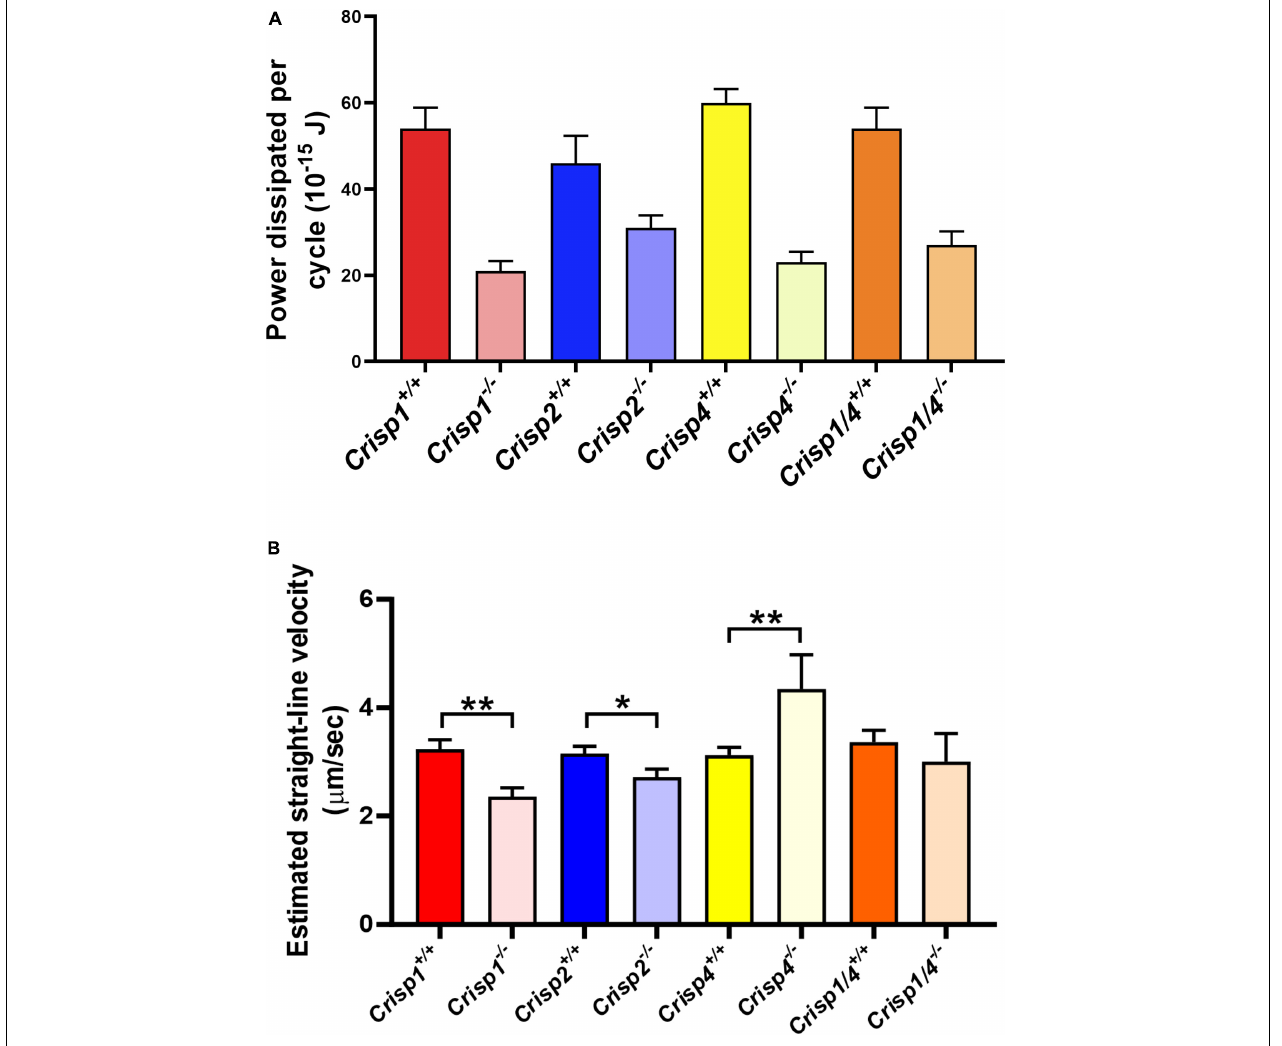
FIGURE 5 | Mathematical estimation of flagellar kinetics of sperm across multiple genotypes. (A) The average hydrodynamic power dissipation (10 − 15 J) rate from spermatozoa from individual mouse strains as a function of genotype. The data presented is from a total number of 25–30 sperm/genotype. N = 5–6 mice/genotype. Data analyzed by two-way ANOVA ( ± SD) on the mean sperm value from individual mice across genotypes. The intense color bars represent Crisp wild type mice data and lighter version of the same color bars represents Crisp knock out mice data, respectively (CRISP1 – red, CRISP2 – blue, CRISP4 – yellow, and CRISP1/4 – orange). For all the possible interactions between wild type vs. knock out genotype please refer to Supplementary Tables 5, 5.1 . (B) The calculated net progressive velocity ( µ m/sec) of sperm plus or minus the presence of individual CRISP genes. Data presented is from a total of 25–30 sperm/genotype. N = 5–6 mice/genotype, * P < 0.05, ** P < 0.01, *** P < 0.001, and **** P < 0.0001 as analyzed by unpaired Student t test. Data presented as mean ± SD. The intense color bars represent Crisp wild type mice data and lighter version of the same color bars represents Crisp knock out mice data, respectively (CRISP1 – red, CRISP2 – blue, CRISP4 – yellow, and CRISP1/4 –